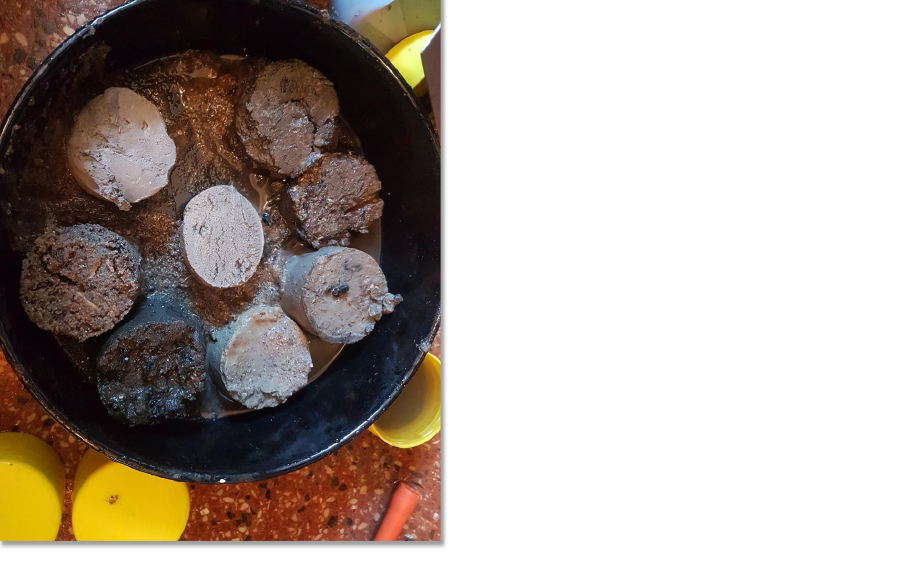
Figure 2. Photograph of sediments (0–2 cm) with different textures and origins in the Warnow River Basin.